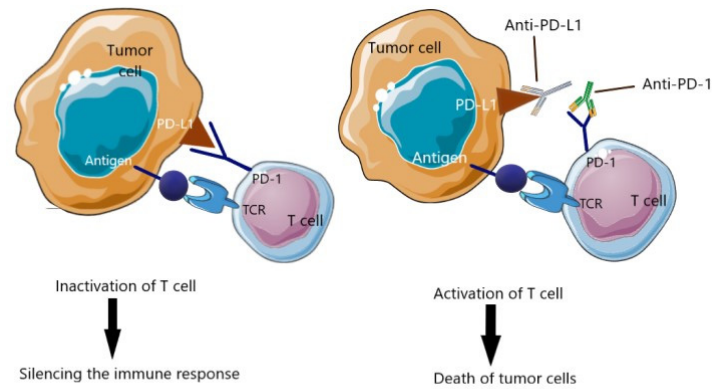
Figure 1. Immune checkpoint inhibitors. The expression of PD-L1 allows tumor cells to switch T-cells off and keep the cancer cells from being killed. The use of immune checkpoint inhibitors permits boosting the immune response to kill the cancer cells. TCR, T-cell receptor; PD-1, programmed death protein 1; PD-L1, programmed death-ligand 1 [Own illustration designed on the basis of [4]]. Drugs including immunotherapeutic agents that are approved for TNBC therapy such as atezolizumab and pembrolizumab as well as other drugs such as AKT inhibitors, monoclonal antibodies, Poly ADP-Ribose Polymerase (PARP) inhibitors and antibody- drug conjugate currently being investigated in TNBC treatment are shown in Figure 2.